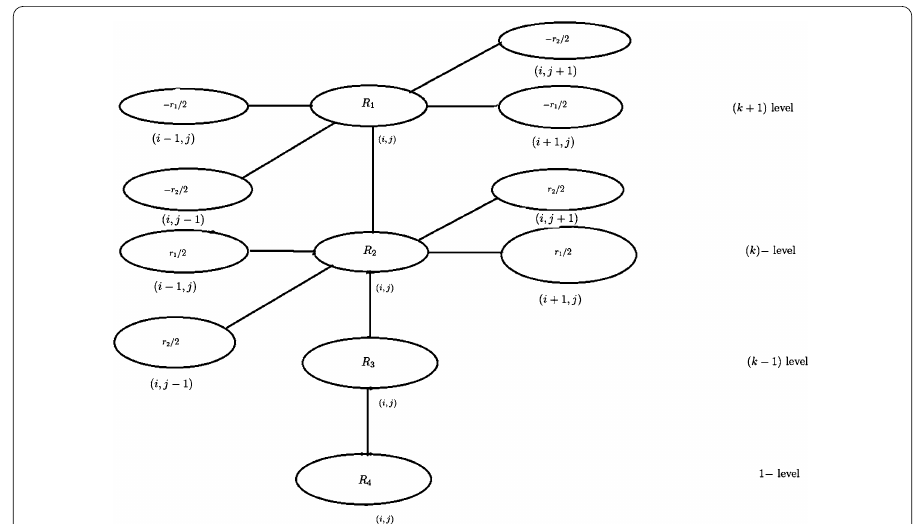
Figure 1 Computational molecule of the FSG(C-N) iterative scheme